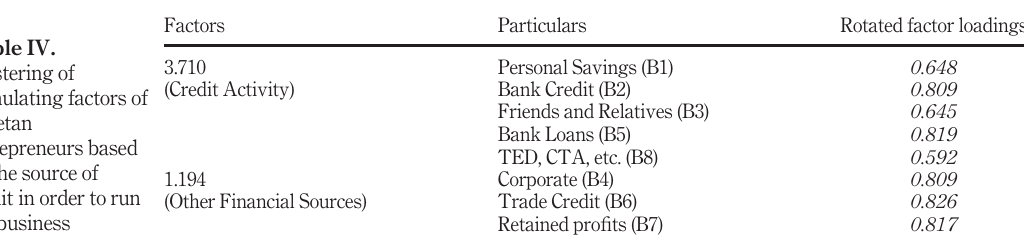
loading on the fi nancial sources of credit